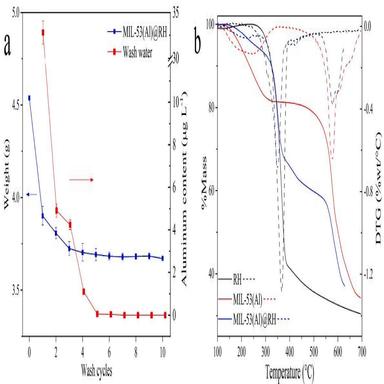
a) Resistance to magnetic stirring and b) thermal stability (TGA-DTG) of the hybrid and its parent independent materials (RH and MIL-53).